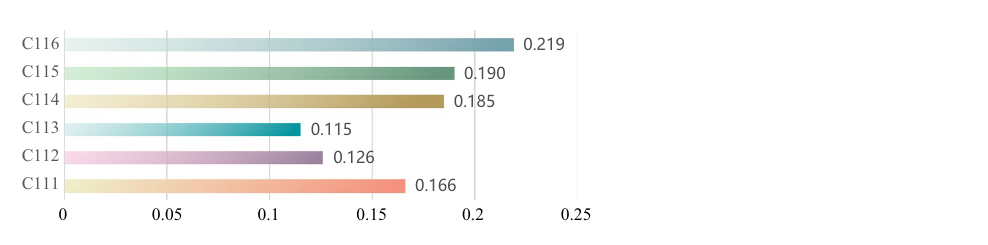
Figure 5. The weights of